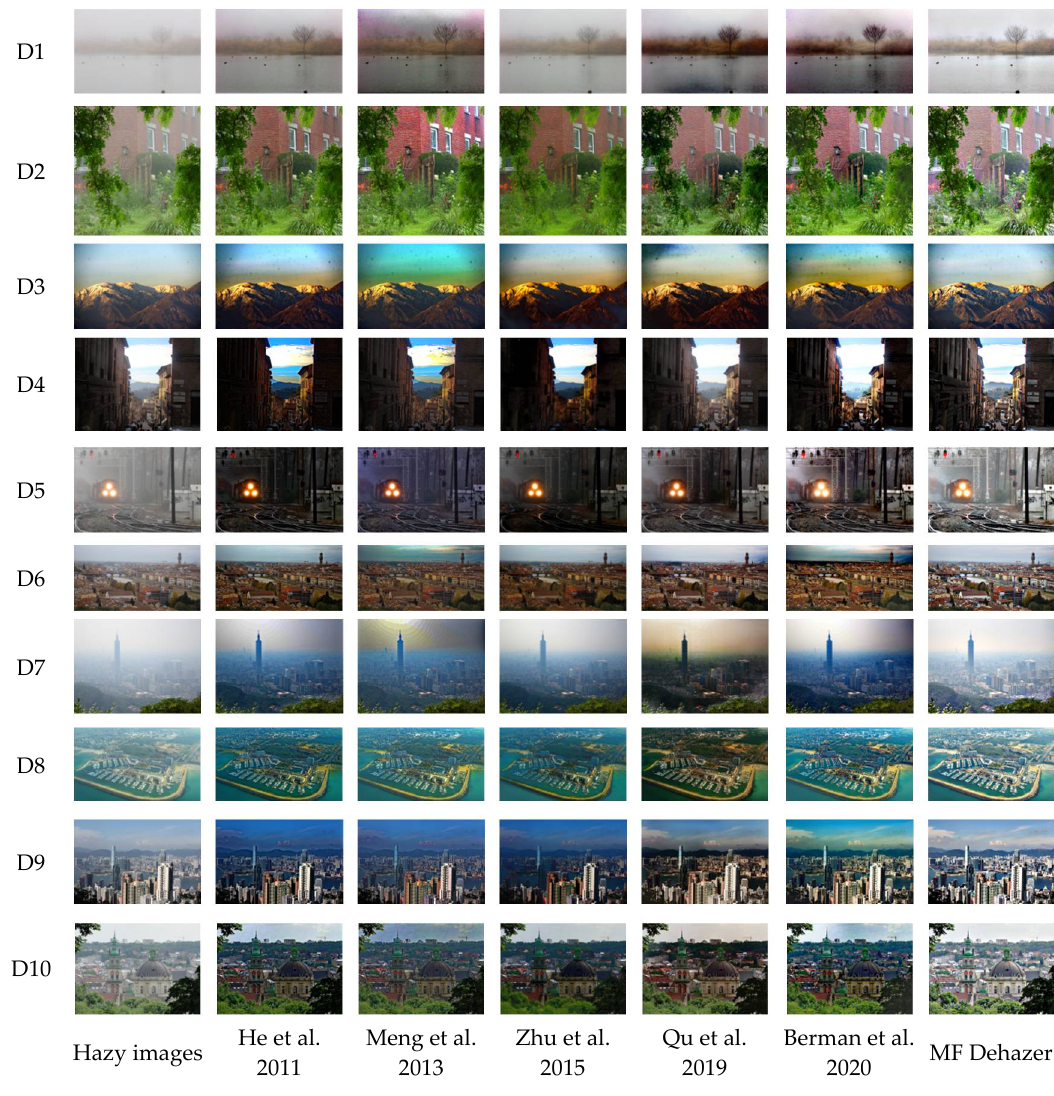
Figure 6. Comparison of daytime dehazing.